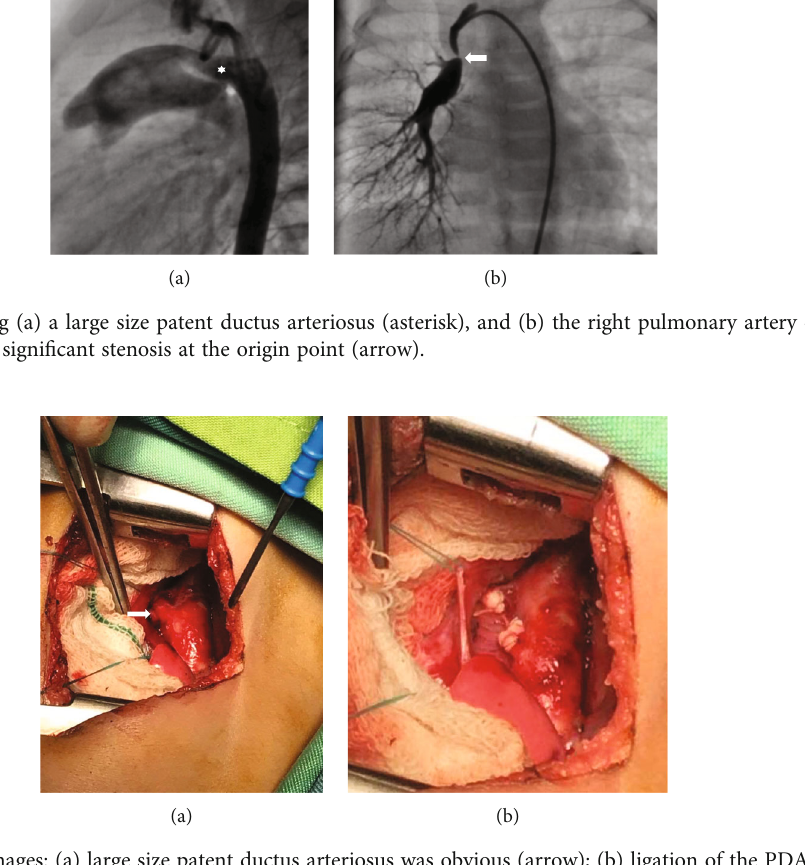
Figure 4: Intraoperative images: (a) large size patent ductus arteriosus was obvious (arrow); (b) ligation of the PDA was performed.